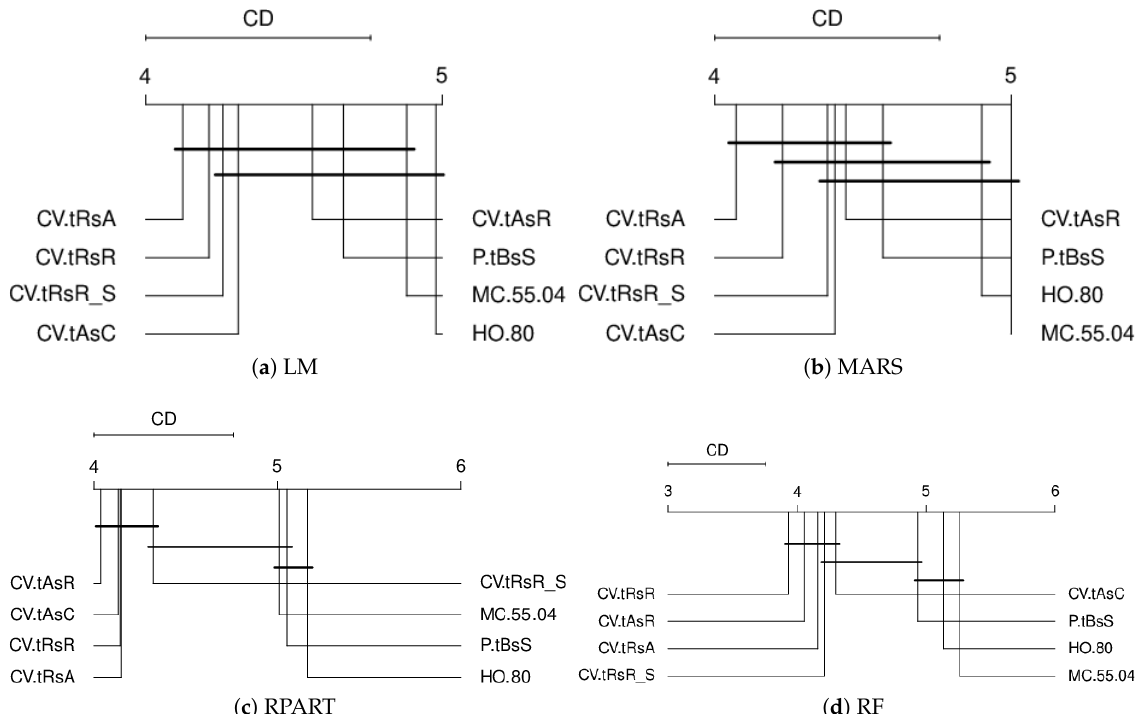
Figure 14. Critical difference diagram according to Friedman–Nemenyi test (at 5% confidence level) for a subset of estimation procedures using 192 artificial datasets.